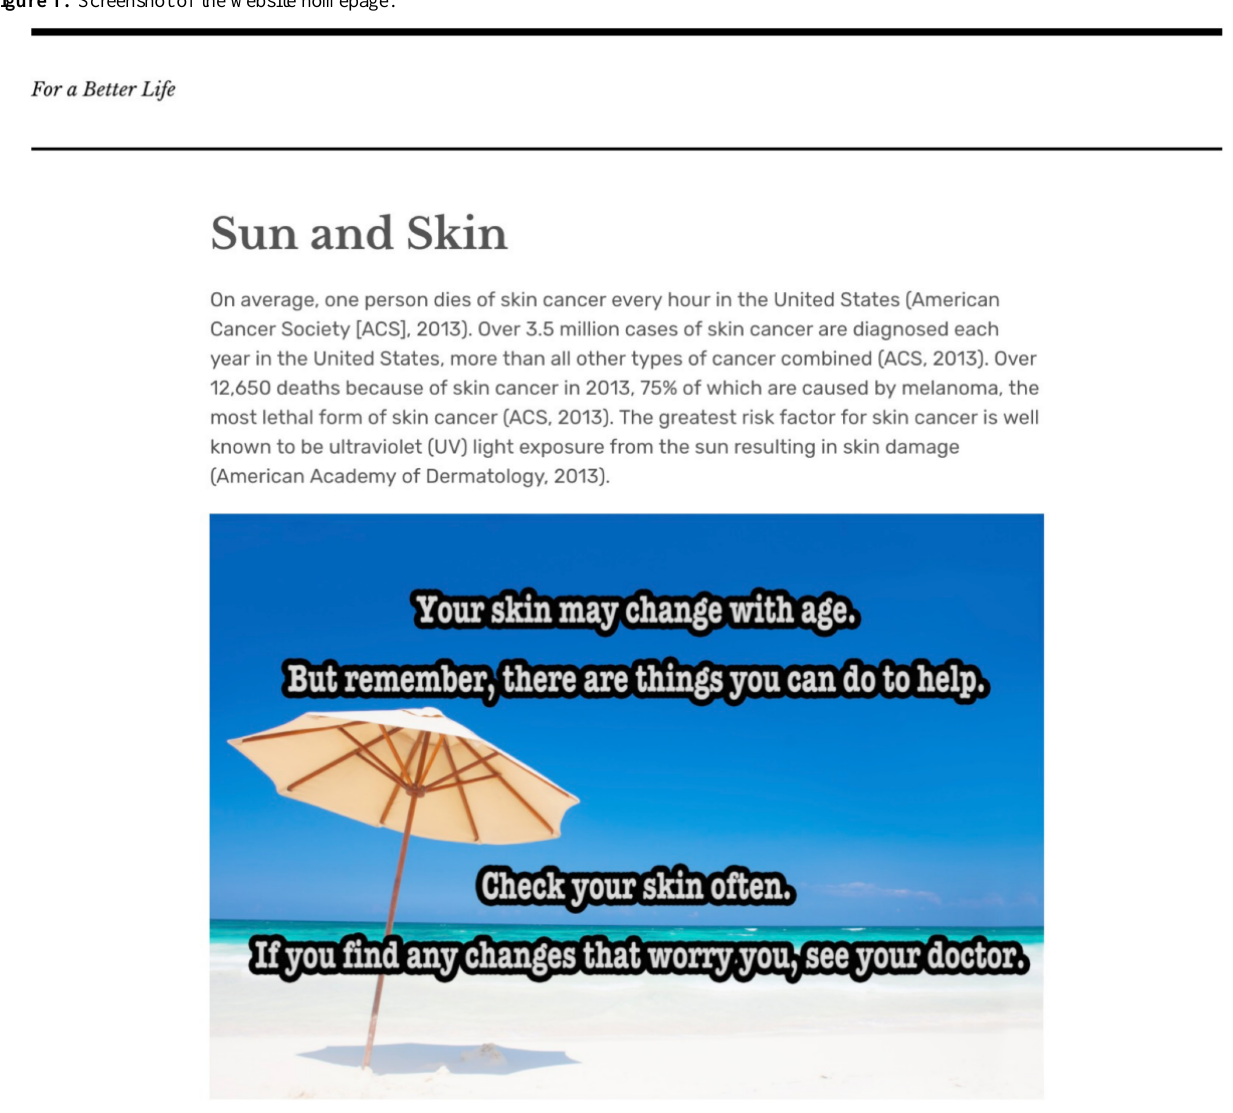
Figure 1. Screenshot of the website